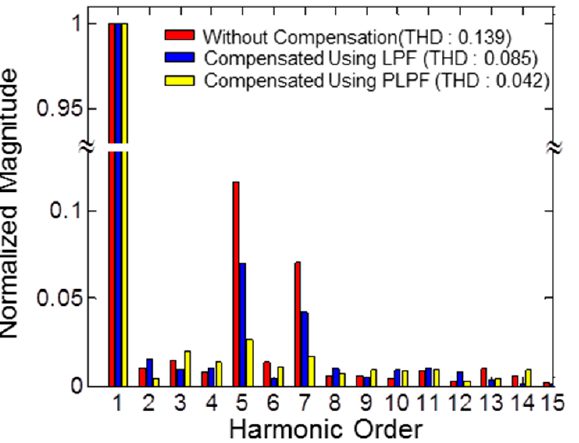
Figure 9. THD analysis results of phase currents according to the compensation methods.